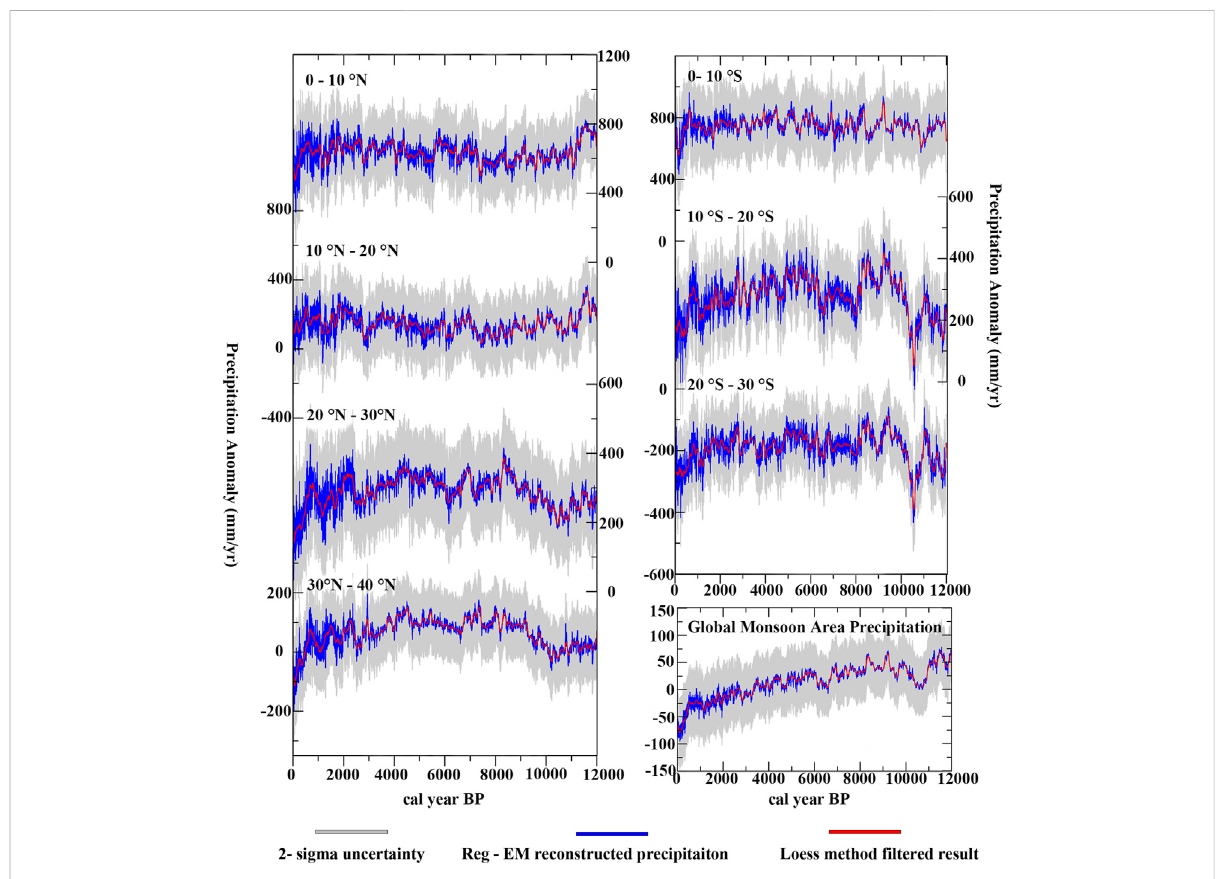
FIGURE 3 Monsoon precipitation reconstructions per 10 latitudinal degrees and different proxies. (A) Monsoon precipitation reconstructions at low latitudes; (B) monsoonprecipitationreconstructionsatmiddlelatitudes;and (C) GMAprecipitationreconstructions.Indicatorsarecitedinthis fi gure: Liang Luar δ 18 O ( ‰ ) values (8 ° 32 ′ S, 120 ° 26 ′ E; 550 m above sea level; Grif fi ths et al., 2009); Dongge Cave δ 18 O ( ‰ ) values (25 ° 17 ′ N, 10 ° 85 ′ E, 680 m abovesealevel;Dykoskietal.,2005;Wangetal.,2005);GISP2 δ 18 O( ‰ )values(72 ° 34.58 ′ N,38 ° 28.08 ′ W,3,208 mabovesealevel;Grootesetal., 1993); Cariaco Basin titanium counts (%) (10 ° 42.73 ′ N, 65 ° 10.18 ′ W, 893 m deep; Haug et al., 2001; Dean, 2007); Florida Straits δ 18 O ( ‰ ) values (24 ° 24.70 ′ N,83 ° 13.14 ′ W,198 mdeep;Schmidtetal.,2012;Domínguez-Villaretal.,2017);KaiteCave δ 18 O( ‰ )values(43 ° 2 ′ N,3 ° 39 ′ W;860 mabove sea level; Domínguez-Villar et al., 2008; Domínguez-Villar et al., 2017); Soledad Basin Mg/Ca (%) (25 ° 12 ′ N, 112 ° 42 ′ W; Marchitto et al., 2010); Laguna Pallcacocha Red Color Intensity (28 ° 46 ′ S, 79 ° 14 ′ W, 4,200 m above sea level; Moy et al., 2002); and Niño3.4 ( ° C) (170 – 120 ° W, 5 ° S-5 ° N; Liu et al.,